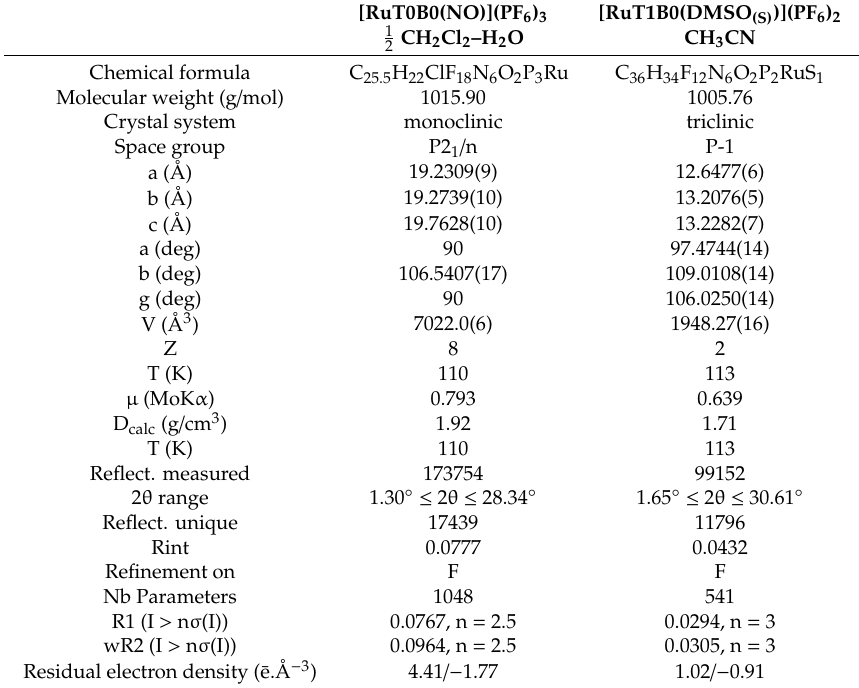
Table 3. Crystal data for [RuT0B0(NO)](PF 6 ) 3 , and [RuT1B0(DMSO (S) )](PF 6 ) 2